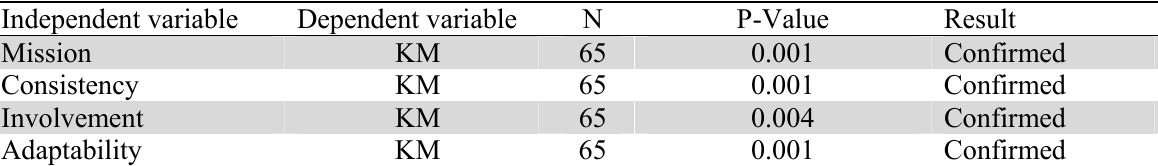
The results of Pearson correlation test Independent variable